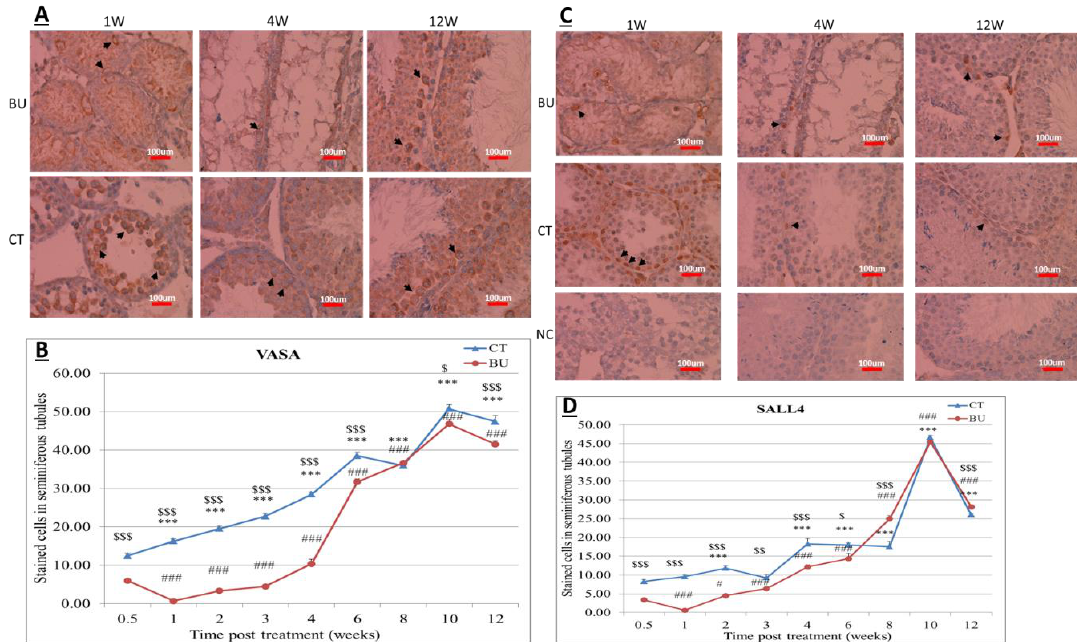
Figure 2. Effect of busulfan (BU) on VASA- and SALL4-positve cells in testicular tissue: BU was i.p injected, as described in Figure 1. Testicular tissue from different time points (1 week, 4 weeks, and 12 weeks) after the BU or control (CT) injection were examined for VASA- and SALL4-positive cells ( A and C , respectively) using immunohistochemical staining. Negative control (NC) of the tissue is presented. Summary of the VASA-positive cell staining/tubule or SALL4-positive cell staining/tubule at different time points (0.5–12 weeks) after the BU or CT treatments is presented ( B and D , respectively). × 40 light microscope magnification (100 µ m scale). $ indicates comparison between control and treatment. * indicates comparison between weeks of control and first week of control. #—indicates comparison between weeks of BU-treatment and first week of BU-treatment. $$$, ***, ### p < 0.001, $$ p < 0.01, # and $ p < 0.05. Black arrows indicate the stained